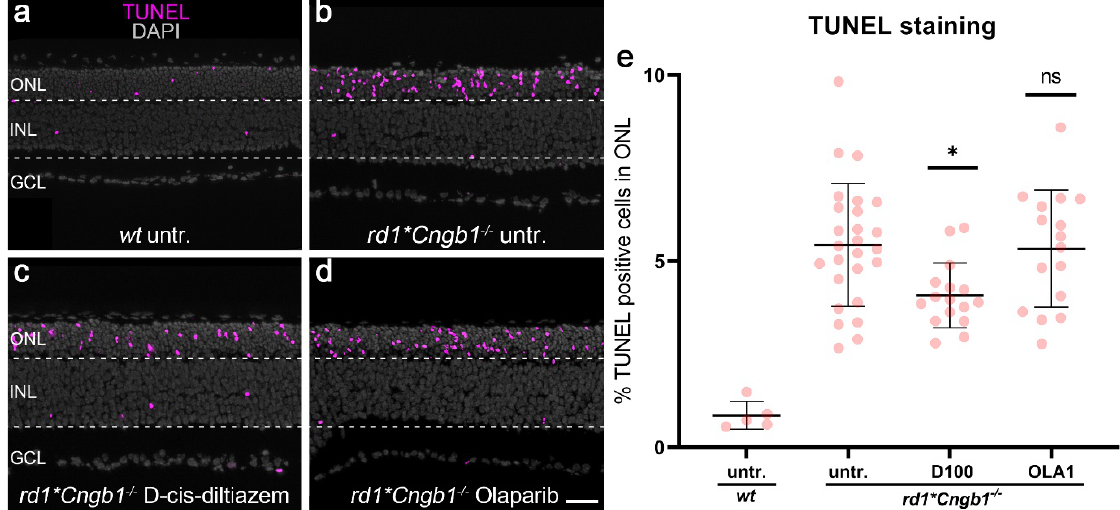
Figure 6. Effects of D-cis-diltiazem and Olaparib on rd1*Cngb1 −/− retinal cell viability. The TUNEL assay labeled dying cells (magenta) in wild-type ( wt ) and rd1*Cngb1 −/− retinal explant cultures. DAPI (grey) was used as a nuclear counterstain. ( a ) In wt retina, only a small fraction of cells in the outer nuclear layer (ONL) were TUNEL-positive. ( b ) Untreated (untr.) rd1*Cngb1 −/− double-mutant retina was compared to retina treated with either 100-µM D-cis-diltiazem (D100, ( c ) or 1-µM Olaparib (OLA1, ( d , e ) The scatter plot shows the percentage of TUNEL-positive cells. Statistical significance was assessed using one-way ANOVA and Tukey’s multiple comparison post hoc testing performed between the control ( rd1*Cngb1 −/− untreated) and 20-µM calpastatin (CAST20), 100-µM D-cis-diltiazem (D100), 1-µM Olaparib (OLA1), and 20-µM calpastatin combined with 1-µM Olaparib (CAST20+OLA1). Only D-cis-diltiazem alleviated the rd1*Cngb1 −/− retinal degeneration. Untr. wt : 5 explants from 3 different mice; untr. rd1 * Cngb1 −/− : 26/26; D100 rd1 * Cngb1 −/− : 16/16; OLA1 rd1 * Cngb1 −/− : 16/16; error bars represent SD; ns = p > 0.05 and * = p ≤ 0.05. INL = inner nuclear layer, GCL = ganglion cell layer. Scale bar = 50 µm.